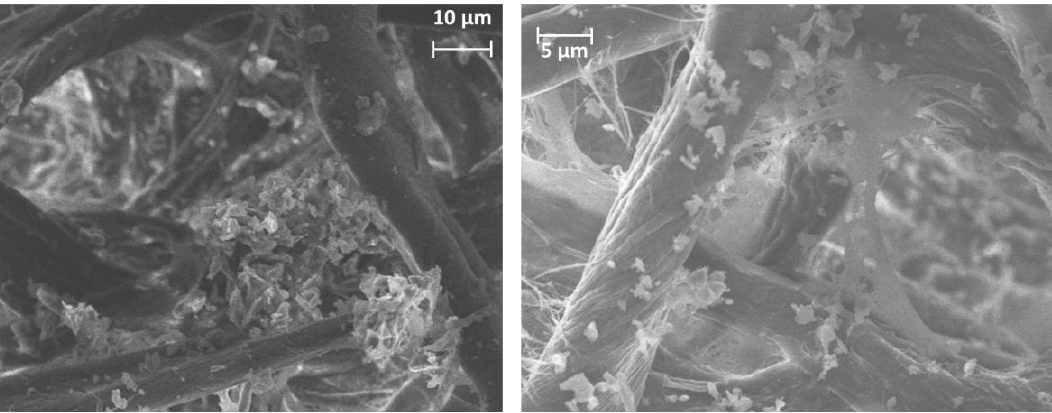
Figure 6. Detail of SEM images including particles collected in filters during the abrasion process.